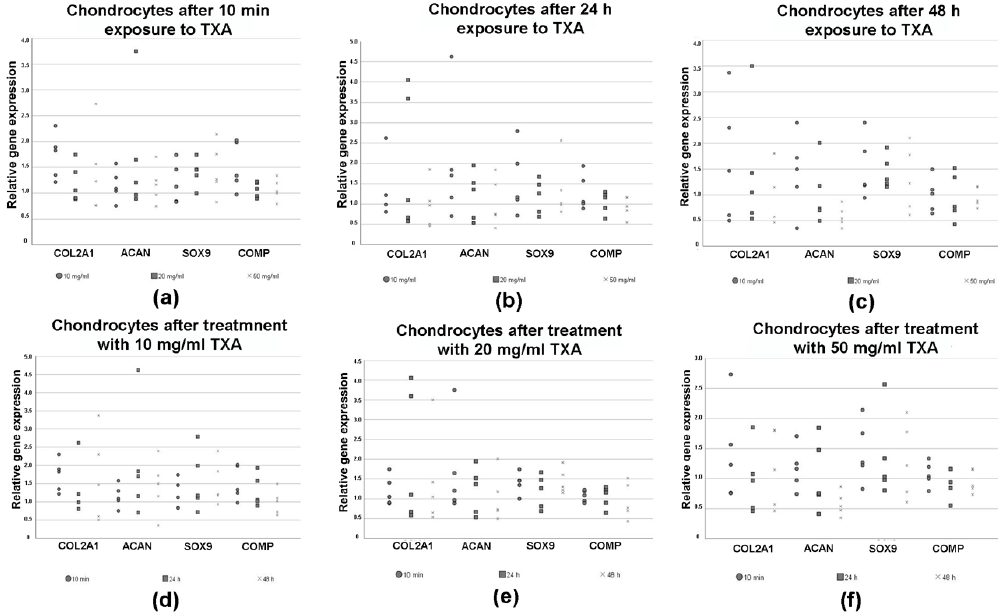
Figure 5. Relative changes in the expression of chondrogenic marker genes pictured as dot plots as measured by semiquantitative RT-PCR in chondrocytes after treatment with 0 mg / mL (no TXA), 10 mg / mL, 20 mg / mL and 50 mg / mL of tranexamic acid for varying exposure times. Chondrocytes were isolated from the hyaline hip cartilage of five patients that underwent total hip arthroplasty. Cells were incubated in cell culture medium and grown to confluency. After reaching confluency, cells were exposed to 0 mg / mL (no TXA), 10 mg / mL, 20 mg / mL or 50 mg / mL of TXA. The exposure time varied from 10 min to 24 h to 48 h. Each dot represents changes in the relative expression of the chondrogenic marker genes aggrecan (ACAN), collagen type II alpha 1 chain (COL2A1), sex-determining region Y-box 9 (SOX9) and cartilage oligomeric matrix protein (COMP) in a single donor sample in dependence of the TXA concentrations ( a – c ) and exposure times ( d – f ). Eukaryotic elongation factor 1 α (EEF1A1) was used as the housekeeping gene and for internal controls. Primer details are illustrated in Table 1. d, days; TXA, tranexamic acid, h, hours; min,